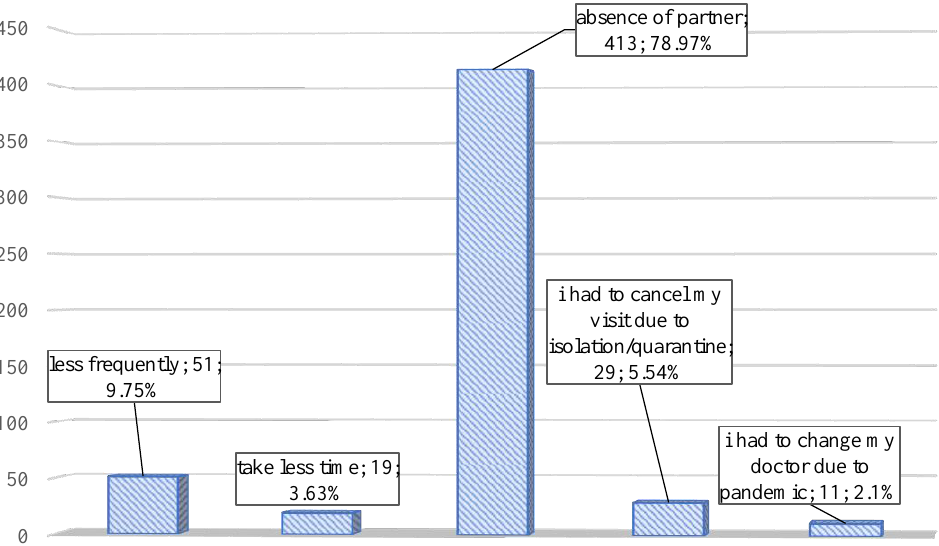
Figure 4. The frequency analysis graph for the answer to the question “How has the SARS-CoV- 2 pandemic affected your pregnancy visits?”.